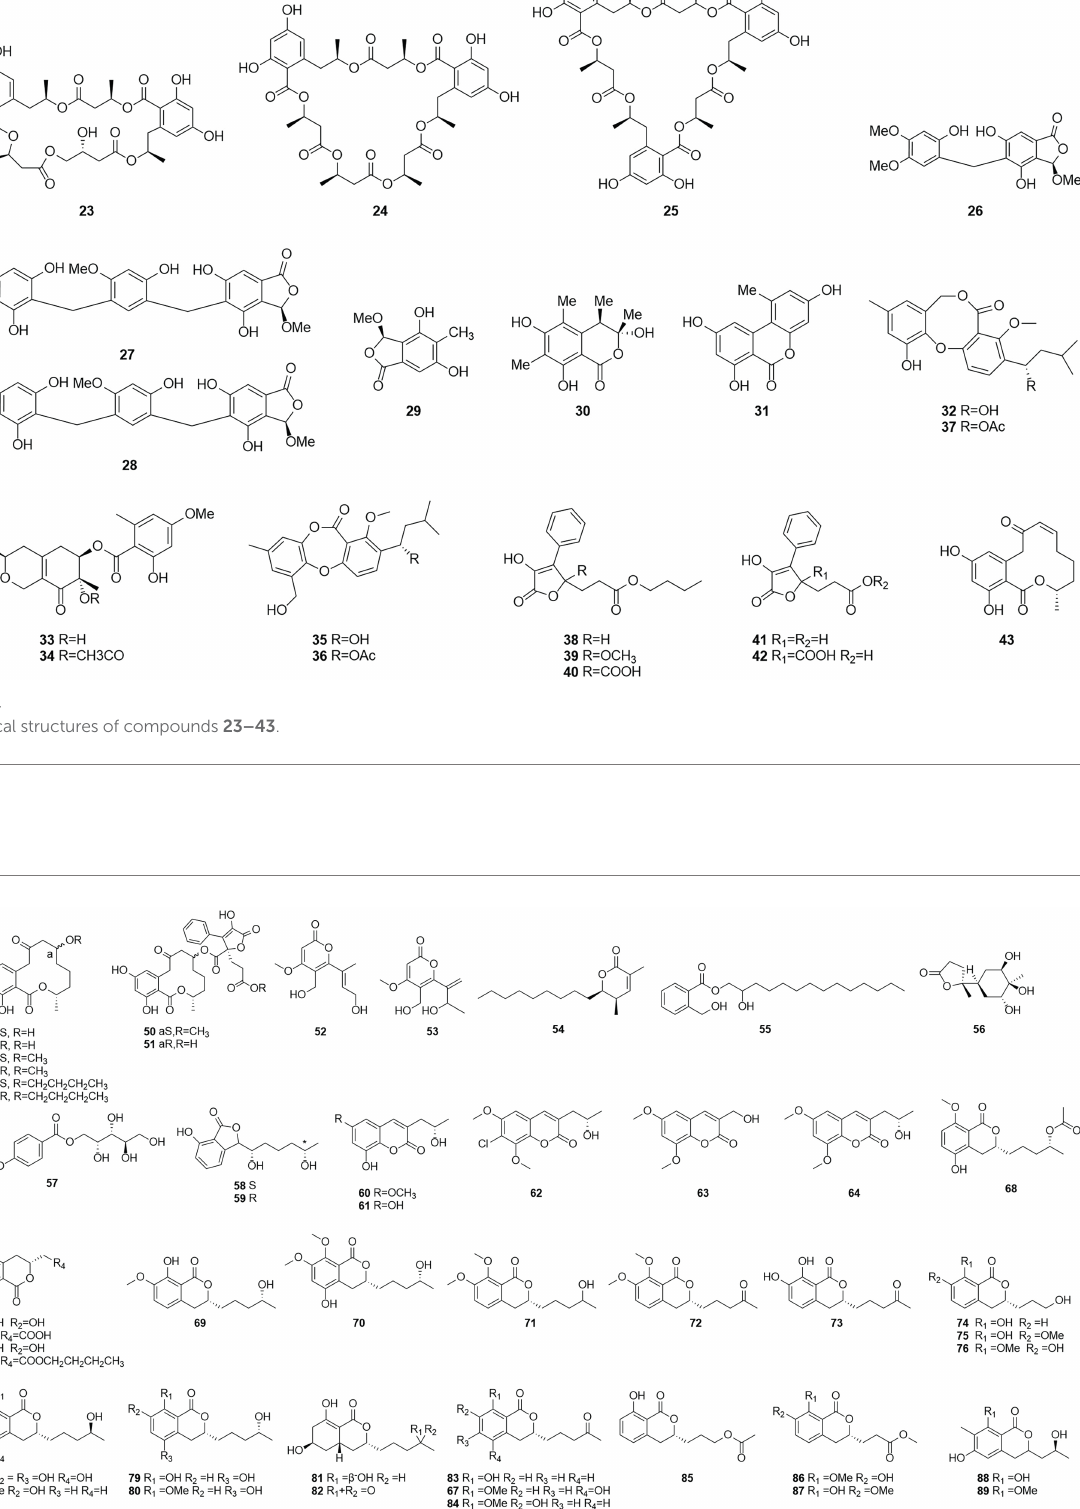
FIGURE 5 Chemical structures of compounds 44–89